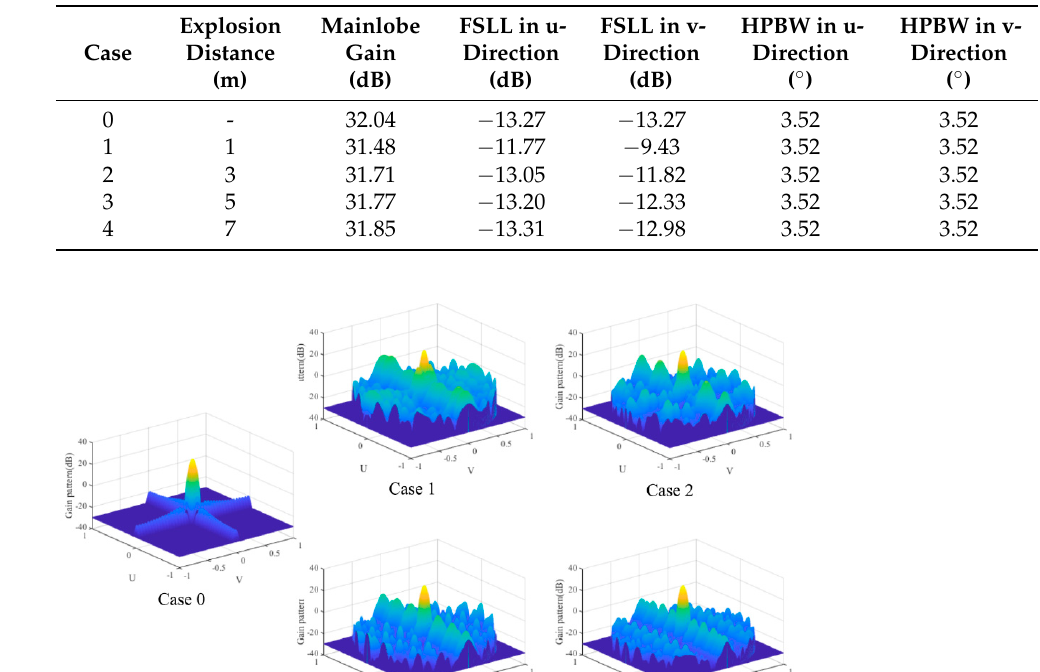
Table 6. Electrical performance parameters at different explosion distances in the transmitting mode.